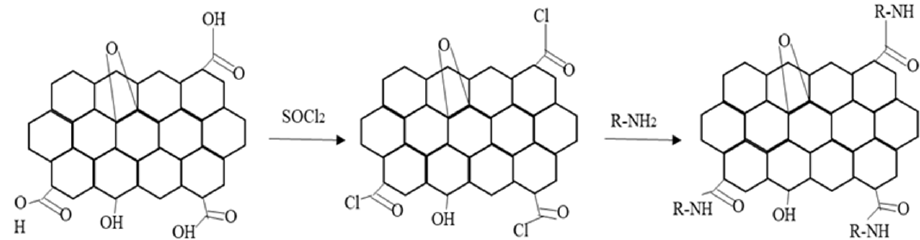
Figure 2. Azide chemical reaction process.